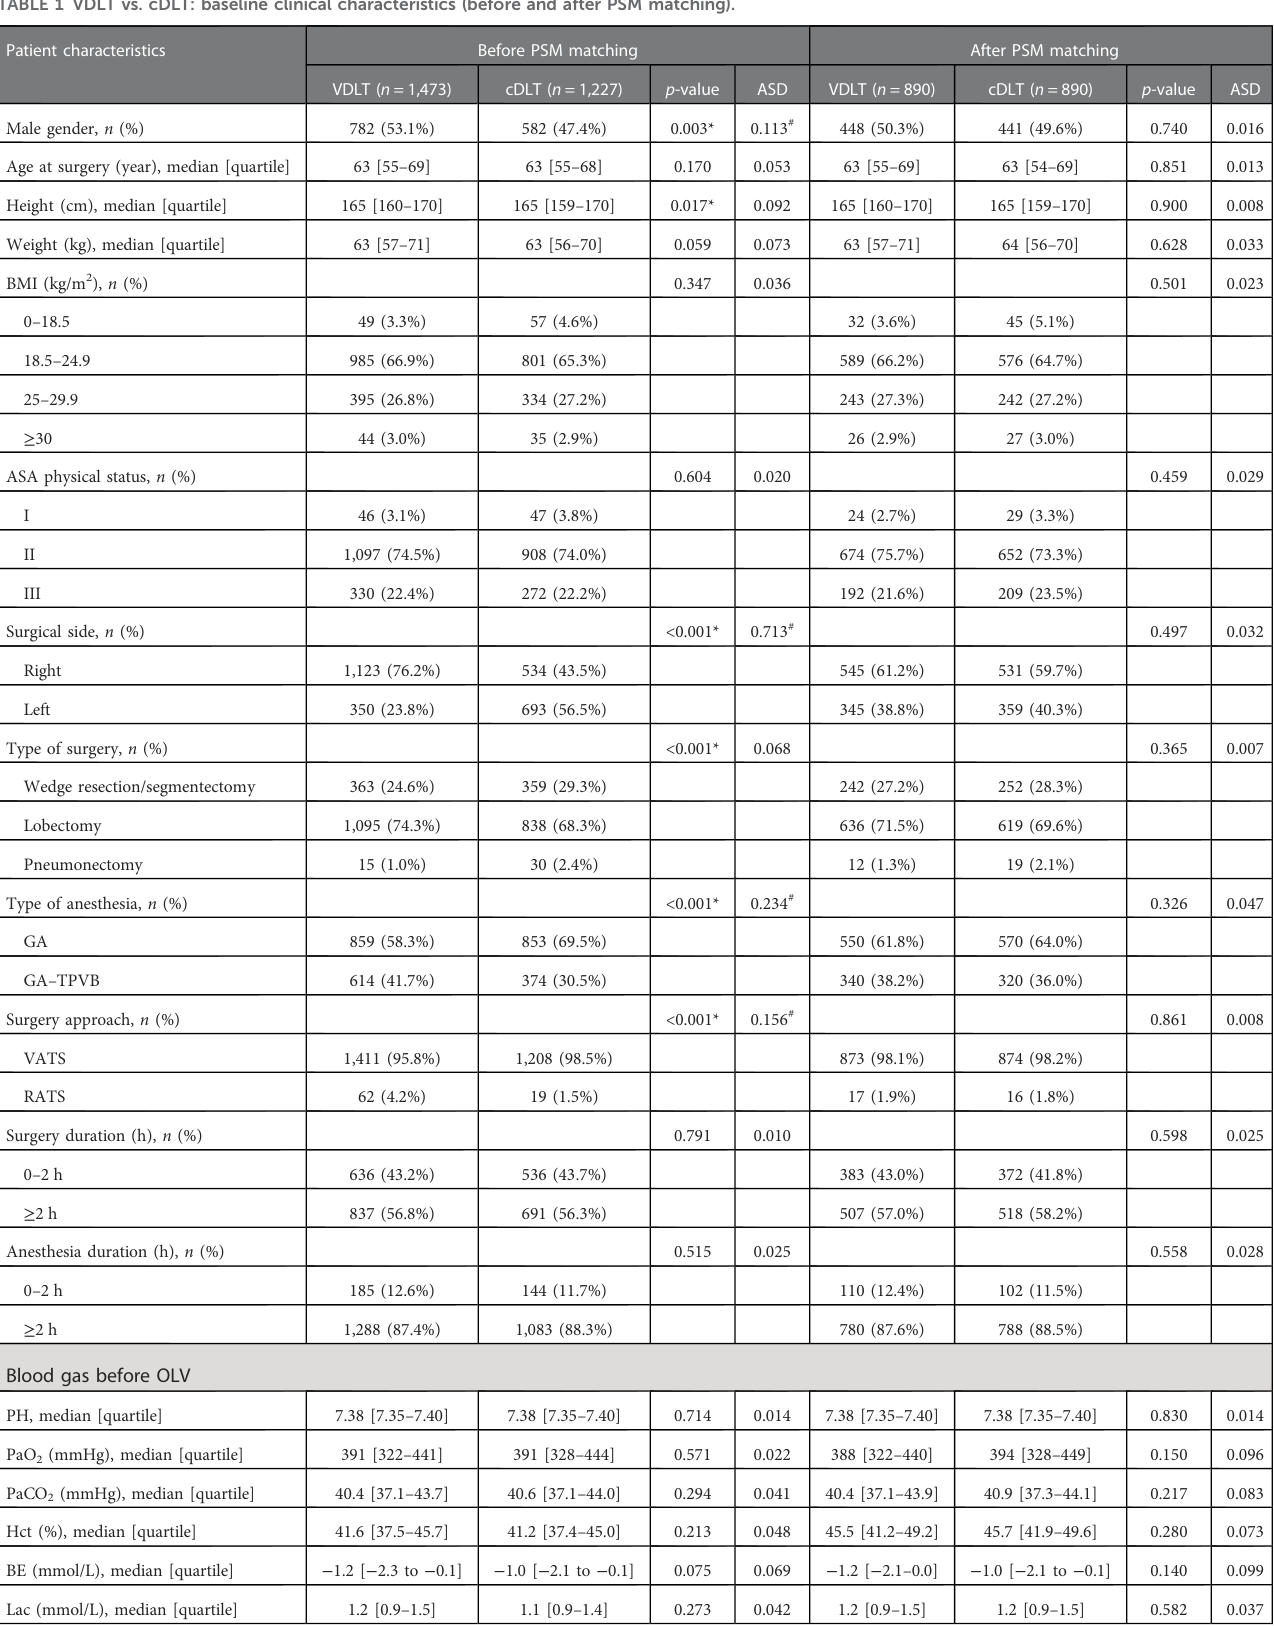
TABLE 1 VDLT vs. cDLT: baseline clinical characteristics (before and after PSM matching).